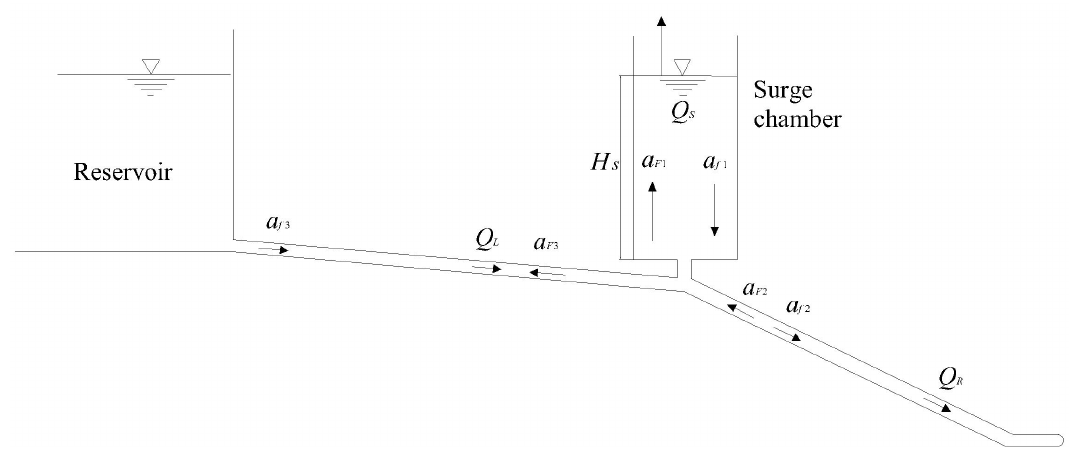
Figure 1. Schematic of a surge chamber ( a F is transmitted wave and a f is reflected wave).